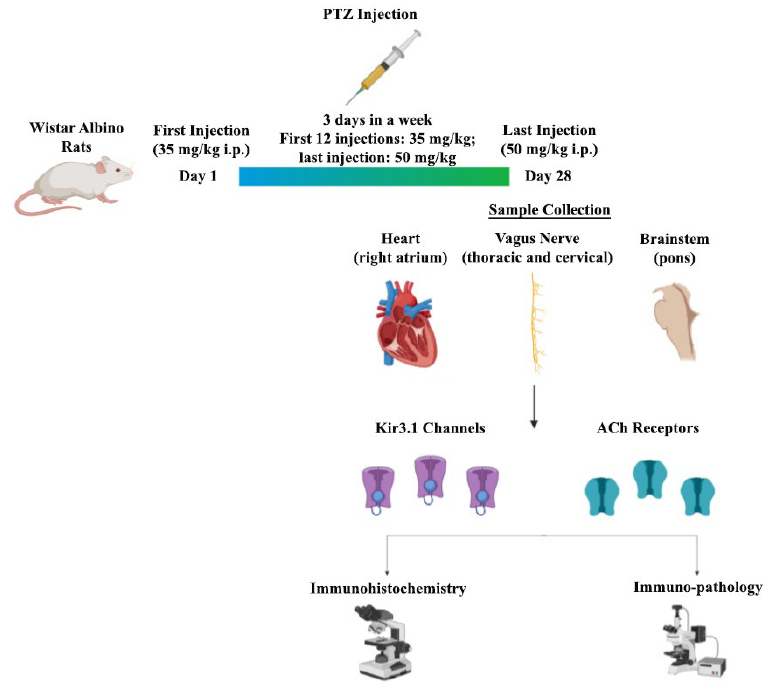
Figure 1. A pictorial representation of an experimental protocol.